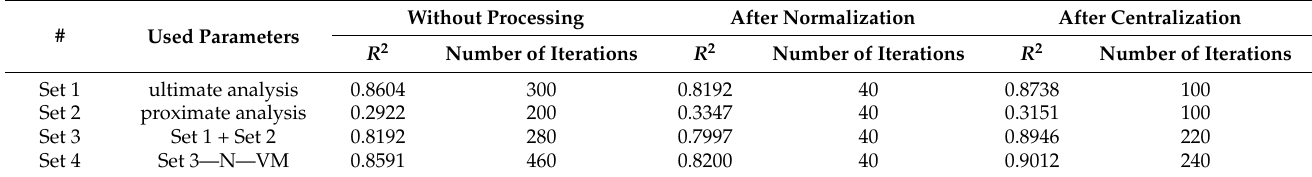
Table 3. Prediction accuracy of the ANN model for different types of dataset preprocessing.